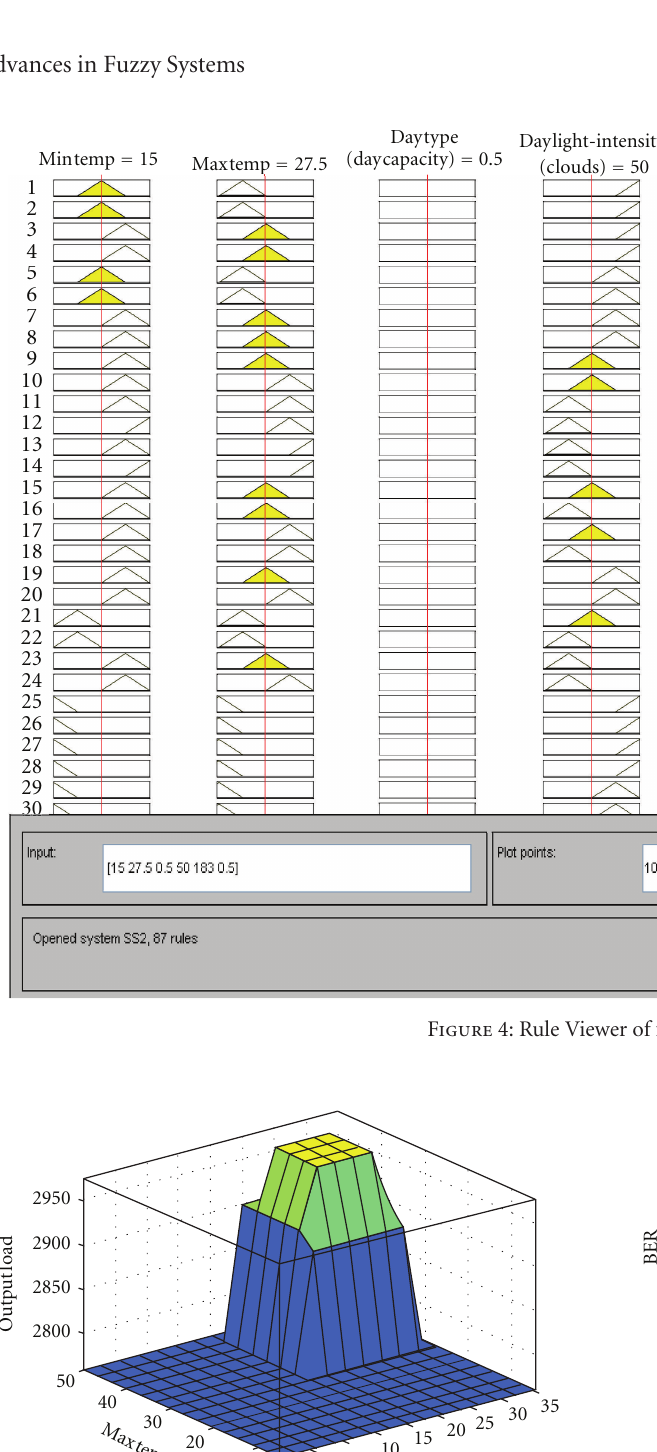
Figure 6: BER Plot of OFDM System with RS encoding and QPSK modulation